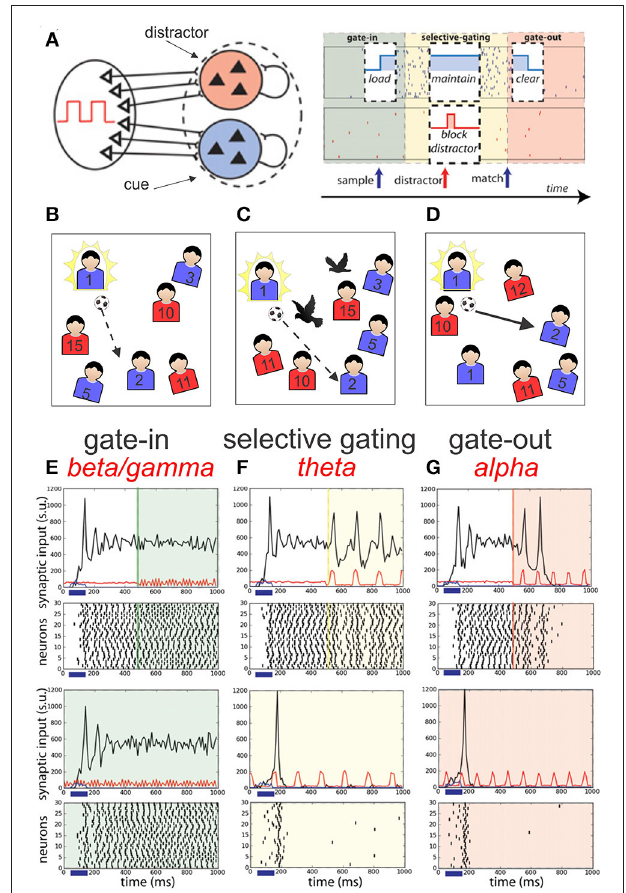
FIGURE 7 | Schematic representation of the network models of Dipoppa and Gutkin (2013) dedicated to a working memory task. (A) Two neuronal populations B (in blue) and R (in red) of recurrent network receiving input by sources modulated by the shared background oscillation. The phases of operations are outlined in a white box showing the succession of the gating modes and operations: (I) Gate-in mode: the sample stimulus (blue arrow) activates population B (load). (II) Selective-gating: the distractor stimulus (red arrow) is not able to activate population R persistently (block distractor) and the memory in population B is held (maintain). (III) Gate-out mode: upon match-stimulus presentation, persistent activity is deactivated in the blue population (clear). Input oscillations enabling the gating modes: beta–gamma band ensures the gate-in mode at the beginning of the task, theta band ensures the selective-gating mode during the delay period (memory maintenance together with protections from the distractors), and alpha band ensures the gate-out mode at the task completion (memory is rapidly cleared). (B–D) Adaptive suggestion of this model into sport context (passing ball in soccer) (see main text for more details). (E–G) Frequency-dependent influence of oscillations on the reverberant spiking persistent state. The network responses (black) to a transient excitatory external stimulus ( t = 50–150 ms) (blue bar and signal) depend on the frequency content of the background oscillatory input. First and third rows show the raster histogram of 30 representative neurons; second and fourth rows show average population input from recurrent connections (black), background activity (red), and external stimulus (blue) in arbitrary/normalized units. For each frequency the background oscillation is switched on either after the stimulus presentation (first and second rows) or before (third and fourth rows). (E) Beta–gamma-band oscillations (45 Hz) are compatible with persistent state maintenance: neither erasing nor blocking is seen.